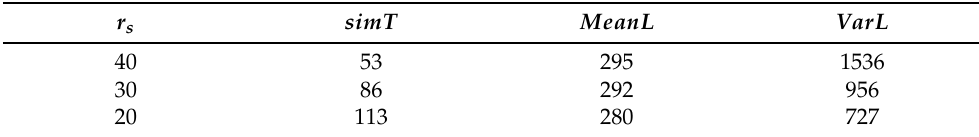
Table 1. The effect of changing the footprint radius r s